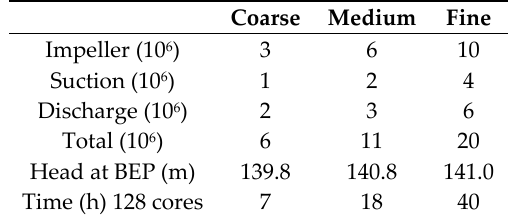
Table 1. Different grid refinements with the pump Head calculated a t the